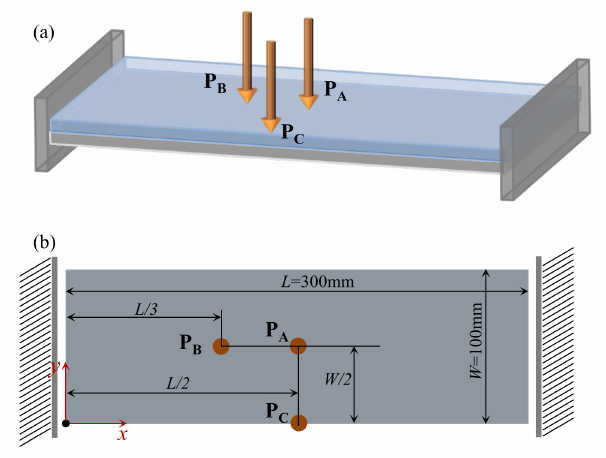
Figure 15. A composite plate clamped on two opposite edges. ( a ) Three-dimensional view. ( b ) Top view of the composite plate.